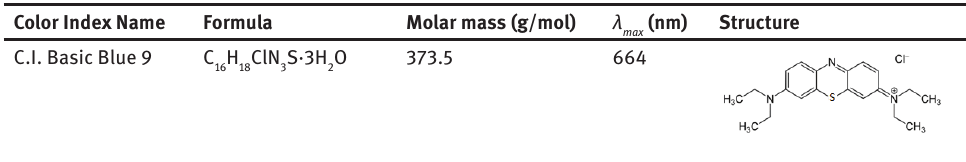
Figure 1: Methodology for synthesis of MgO-ZrO Table 1: Properties of the model organic